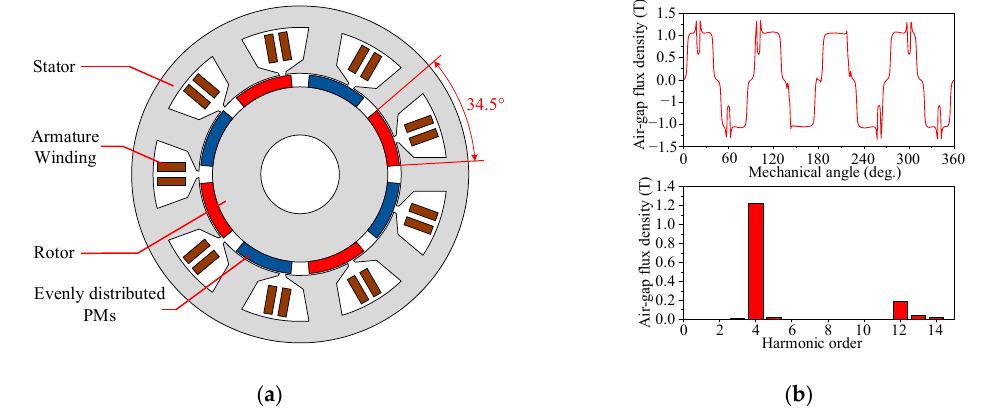
Figure 1. 9-slot/8-pole conventional PM motor: ( a ) motor structure; ( b ) air-gap flux density waveform and